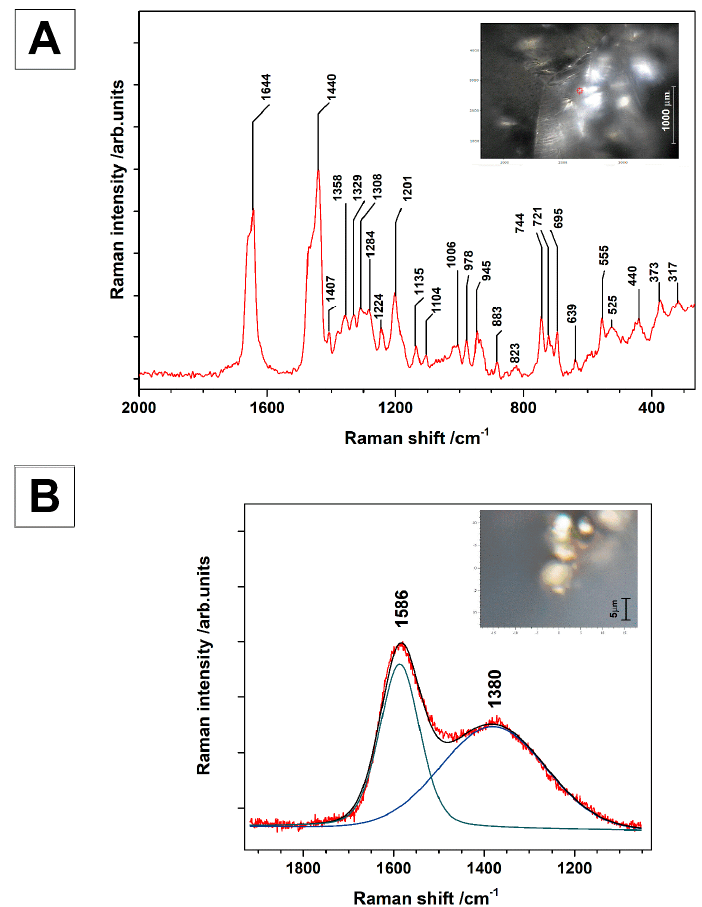
Figure 8. The RS spectra of two types of Dominican fossil resins; ( A ) type I fossil resin; ( B ) type II fossil resin.